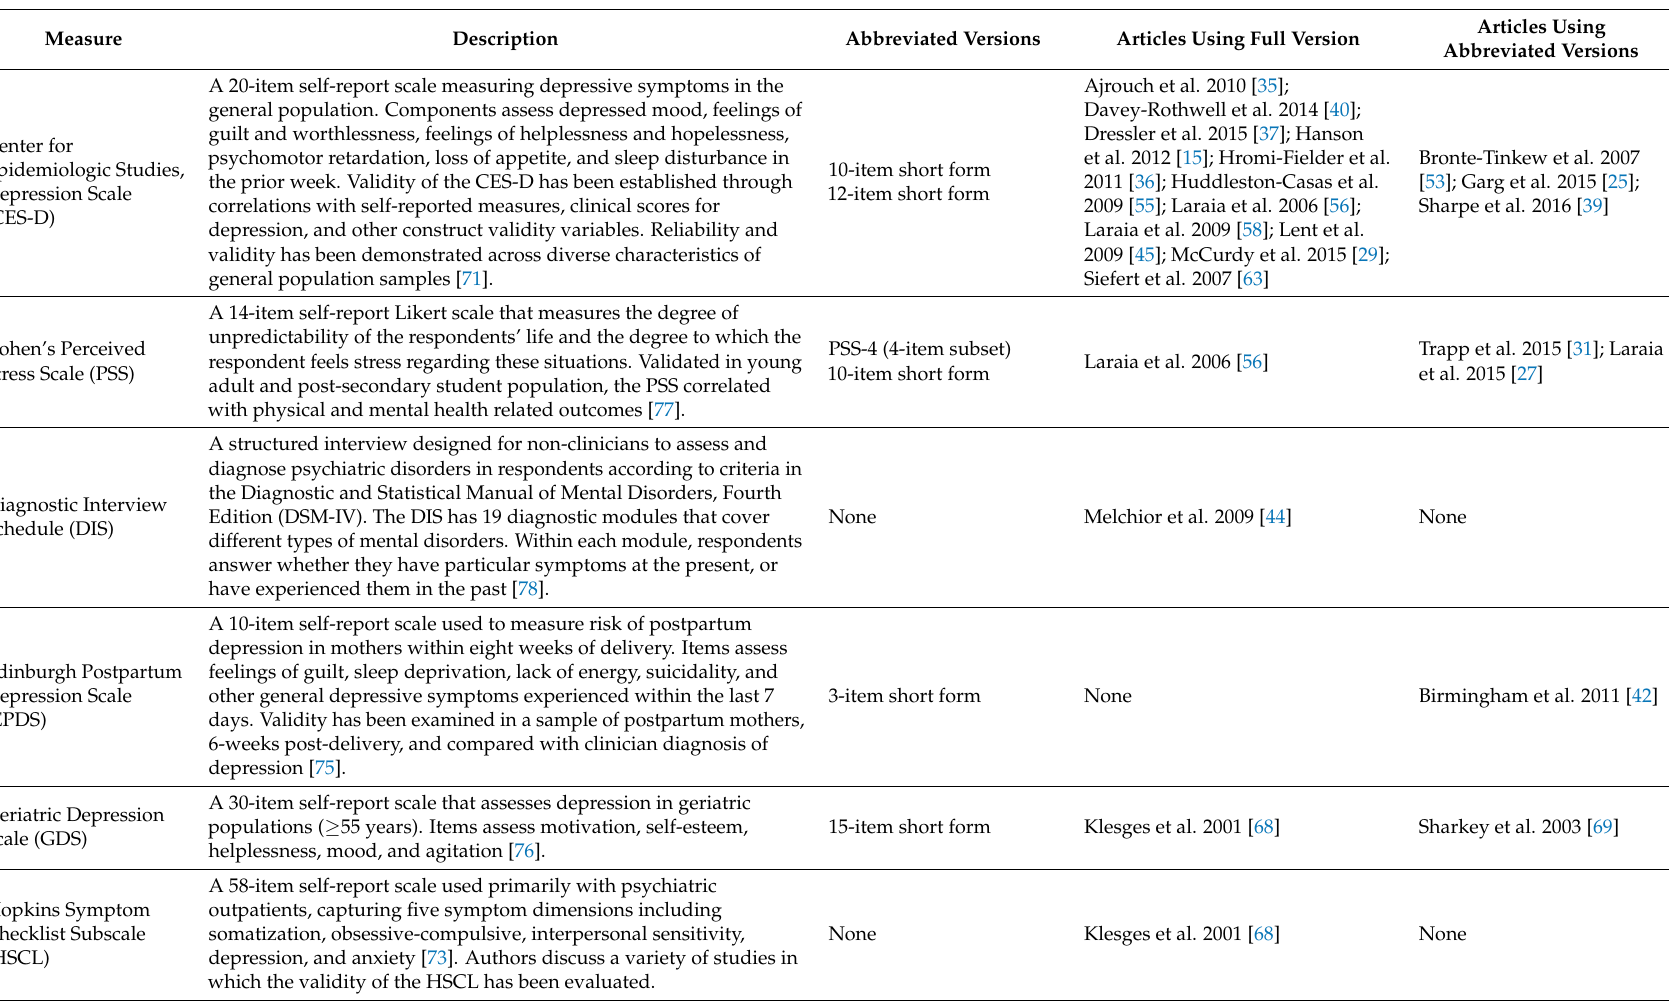
Table 2. Overview of measures of mental health drawn upon in articles ( n = 39) examining associations between food insecurity and mental health among women in high-income